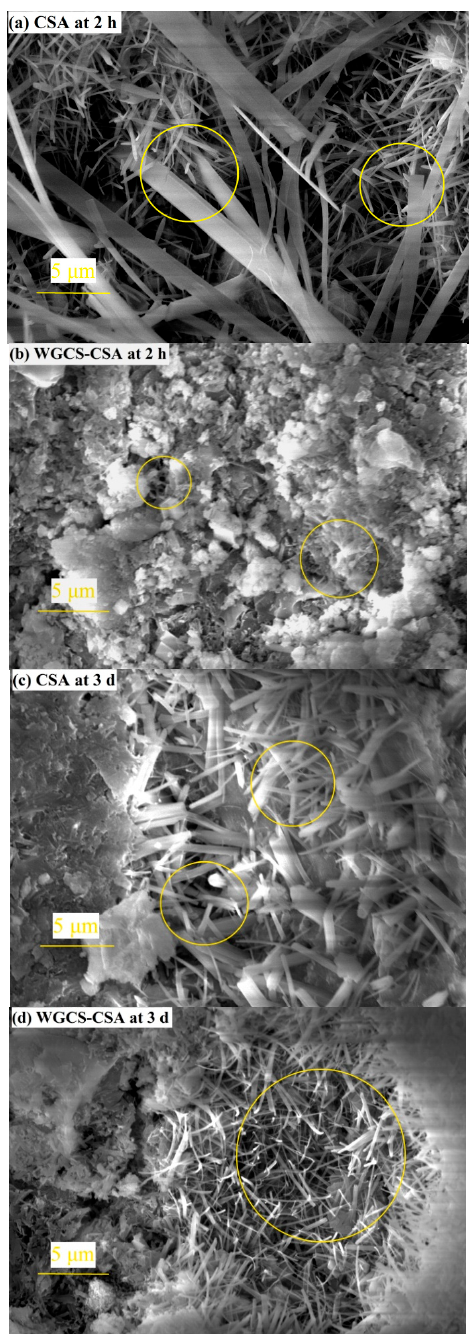
Figure 8. SEM images of CS–CSA paste. ( a ) CSA at 2 h; ( b ) WGCS-CSA at 2 h; ( c ) CSA at 3 d; ( d ) WGCS-CSA at 3 d.